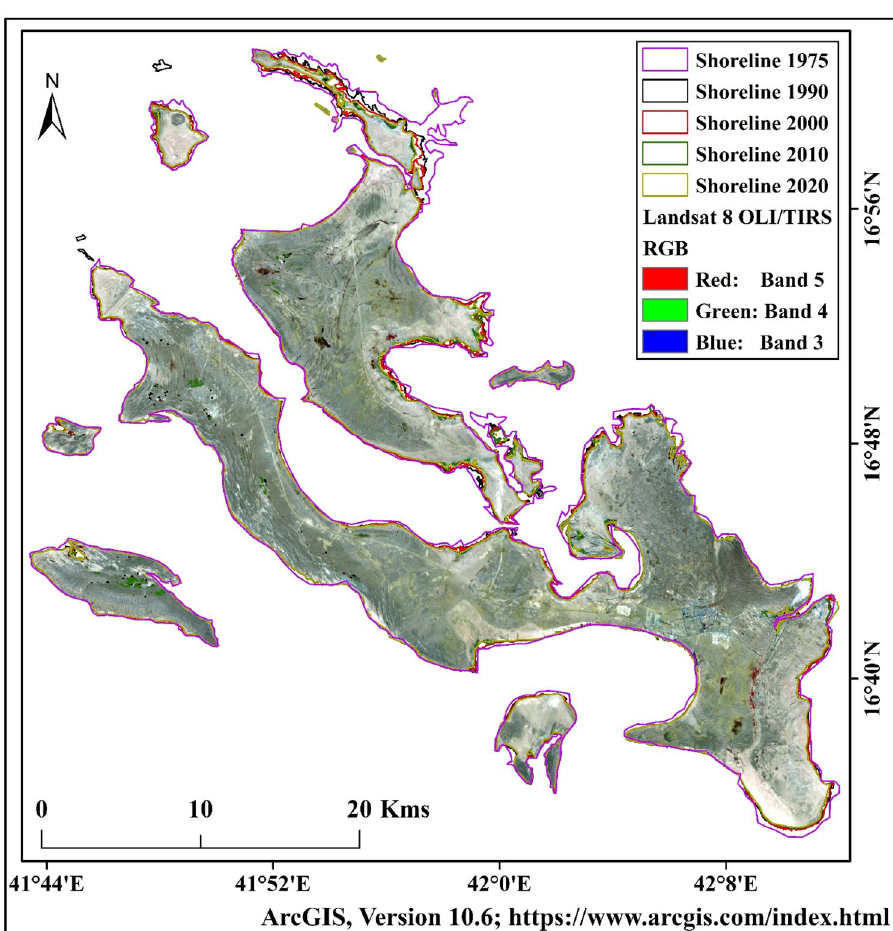
Figure 9. Graphical summary of the shoreline changes analysis maps of the Farasan Islands for different periods 31,64 . The satellite data was downloaded from USGS earth explorer (https:// earth explo rer. usgs. gov/). The map was generated using ArcGIS software, version 10.6 (https:// suppo rt. esri. com/ zh- cn/ produ cts/ deskt op/ arcgis- deskt op/ arcmap/